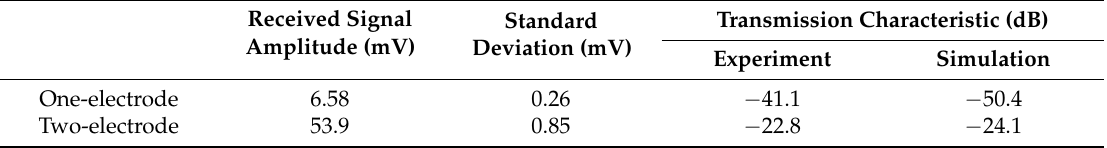
Table 3. Received signal amplitude measured by